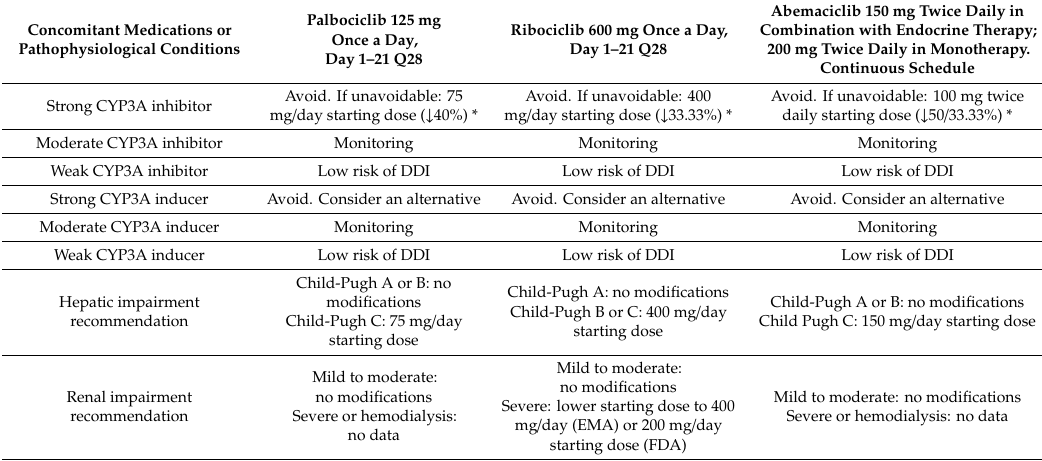
Table 4. Dose adjustments suggestions according to concomitant medications and clinical